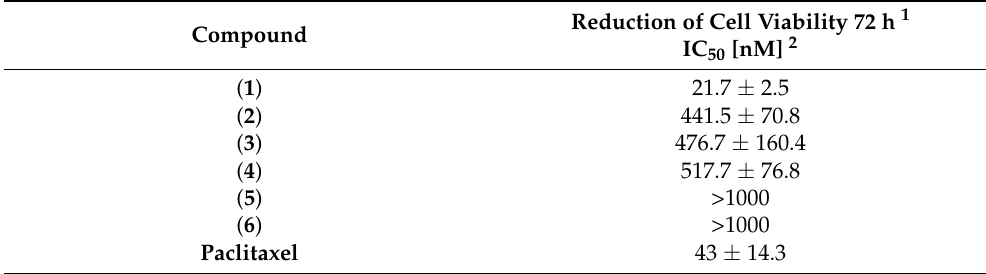
Table 2. IC 50 -values determined for the reduction of cell viability in the 3D co-culture spheroids.